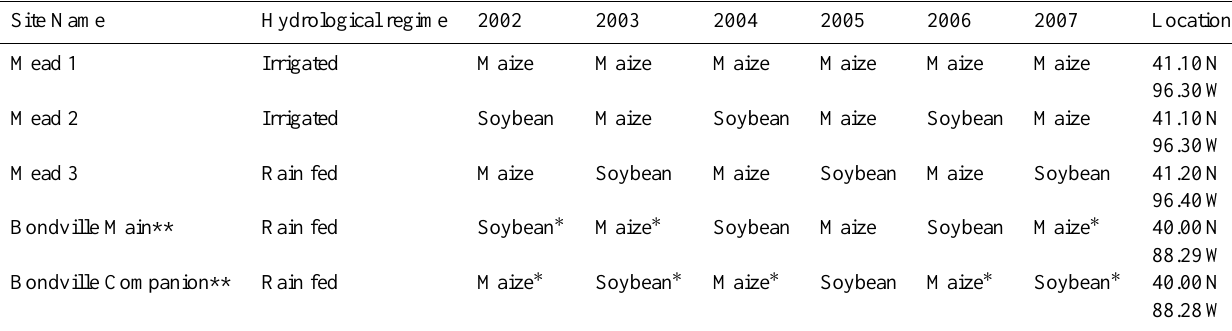
Table 1. Descriptions of flux tower sites used in the